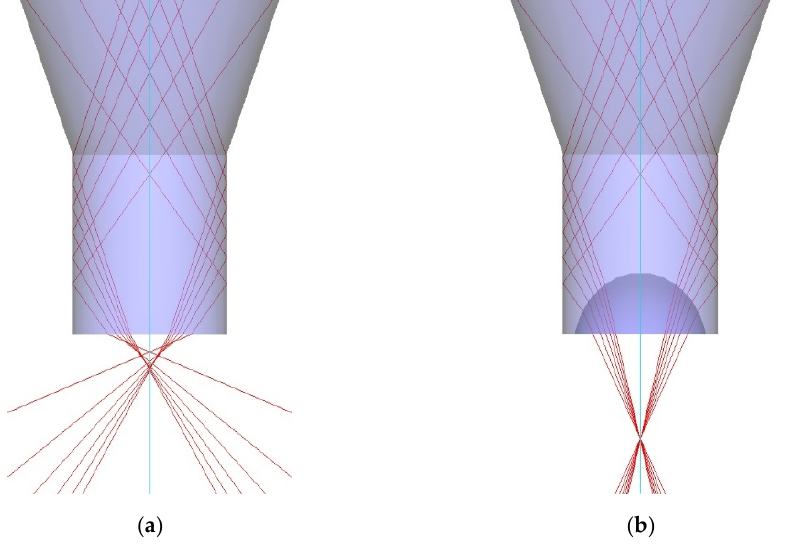
Figure 3. ( a ) Ray tracing simulation for a flat outlet concentrator. ( b ) Ray tracing simulation for a concave outlet concentrator.